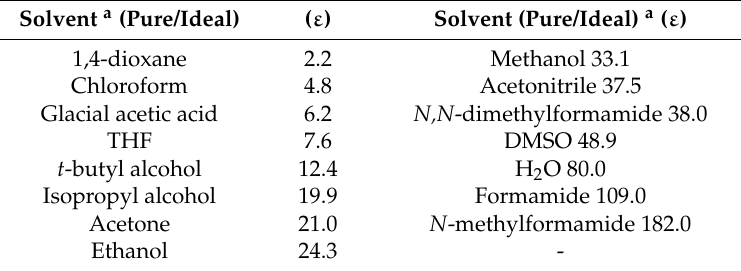
Table 1. Solvents used in the